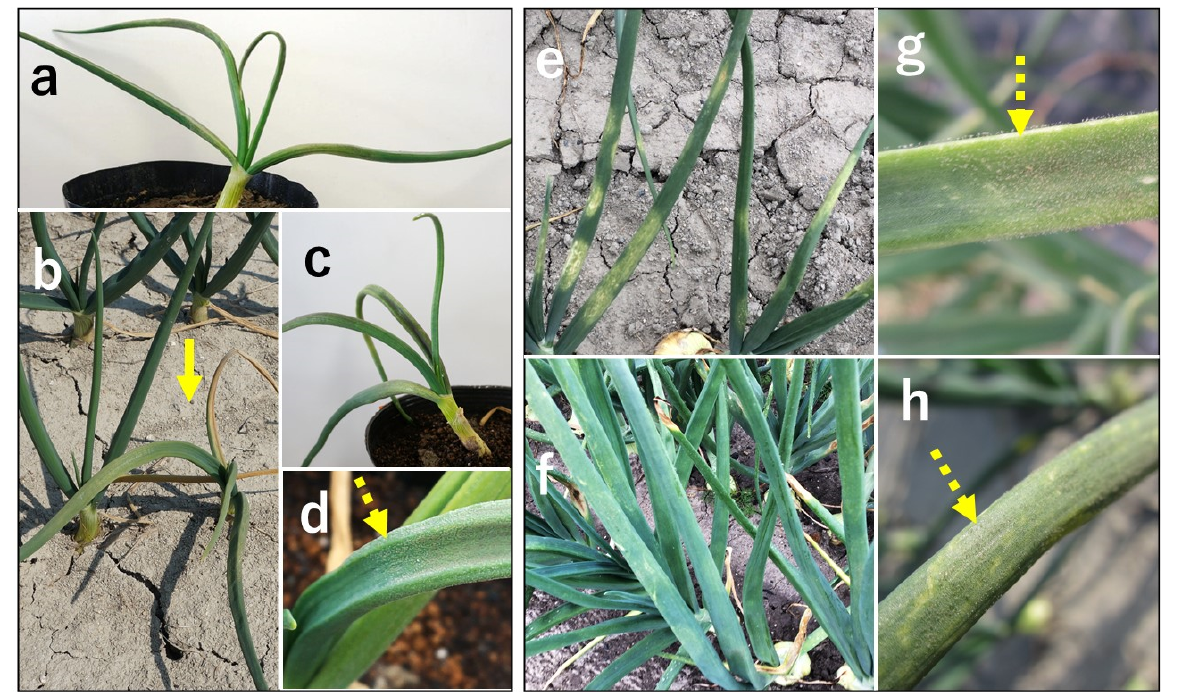
Figure 2. Symptoms of onion downy mildew induced by ( a – d ) primary infection and ( e – h ) secondary infection. ( b ) Solid arrow shows infected onion plants; ( f ) initial symptoms; ( d , g , h ) dashed arrows show sporangia formed in onion plants. Photographs were taken in ( g ) April 2016, ( a – d ) March 2017, ( e , h ) April 2018, and ( f ) May 2018.